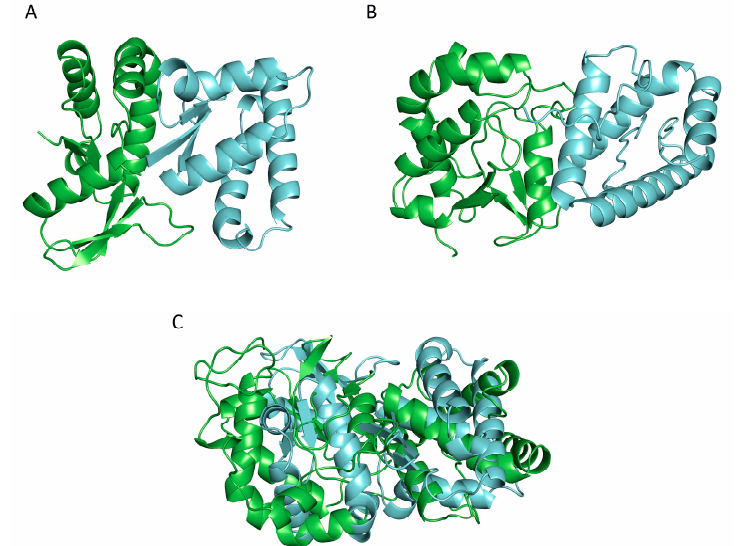
Figure 3. The challenge of making the transition from tertiary to quaternary structure prediction—a hetero dimer prediction. The success of modelling a complex is reliant on the quality of the starting tertiary structure model. ( A ) Observed structure of T0868/T0869 dimer; ( B ) Predicted structure of T0868/T0869 dimer from poor quality initial tertiary structures; ( C ) Superposition of observed and predicted T0868/T0869 dimer with the observed dimer coloured green and the predicted dimer colored blue, aligned with PyMOL.